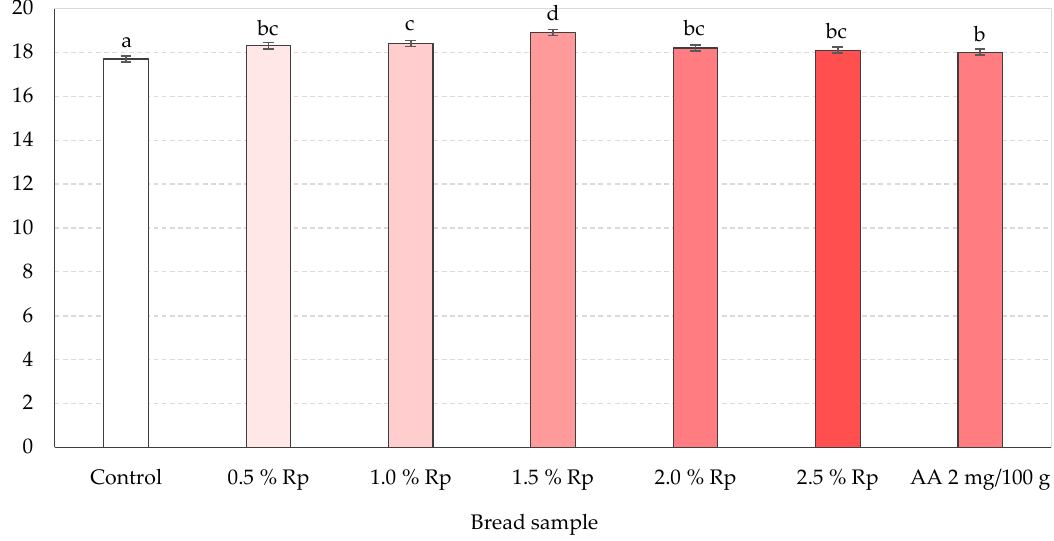
Figure 8. The total score of the 20-point sensory test. Different lower-case letters represent statistically different mean values ( p ≤ 0.01). Rp—rosehip powder, AA—ascorbic